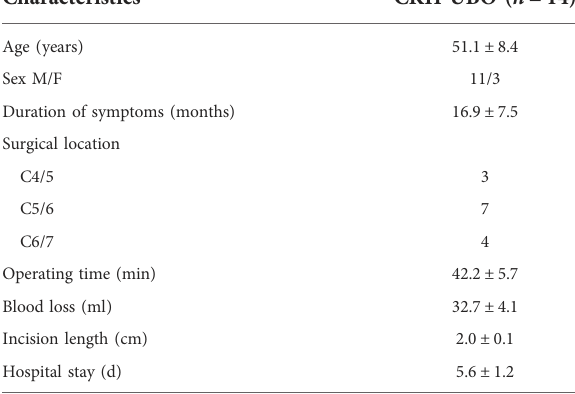
TABLE 1 Summary of the baseline